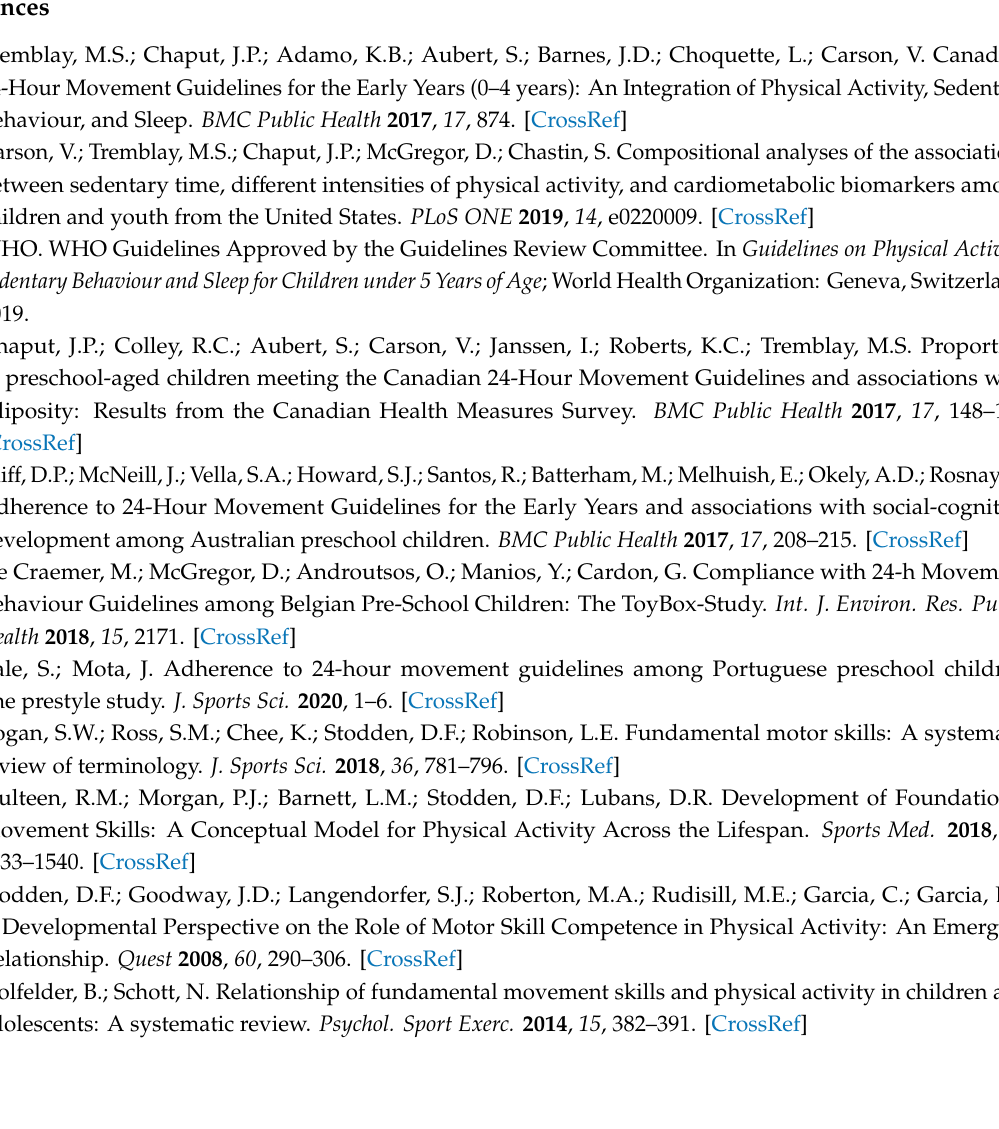
Table S1: Weights